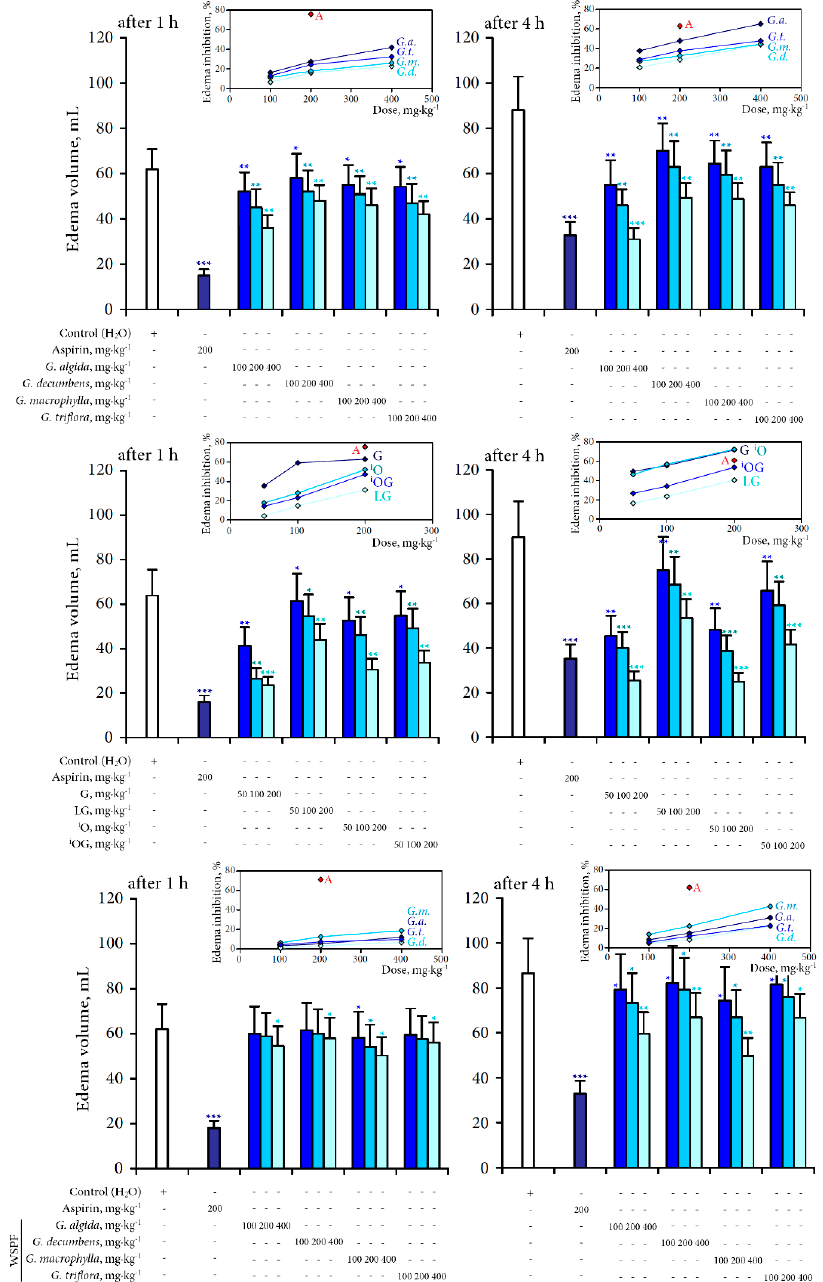
Figure 2. Anti-inflammatory activity of four gentian teas and individual compounds on carrageenan-induced paw edema in rats after 1 and 4 h after injection. Bars show the values of edema volume (mL). Values of edema shown are mean ± SD ( n = 12). Asterisks indicate statistically significant values from the control (*— p < 0.05; **— p < 0.01; ***— p < 0.001). On cuts—percentage of edema inhibition (A—aspirin, G.a. — G. algida , G.d—G. decumbens , G.m. — G. macrophylla , G.t. — G. triflora , G—gentiopicroside, LG—loganic acid-6 ′ - O - β - D -glucoside, i O—isoorientin, i OG—isoorientin-4 ′ - O - β - D -glucoside, WSPF—water-soluble polysaccharide fractions). Anti-inflammatory activity of water-soluble polysaccharide fractions of four gentians characterised as week after 1 h after injection of phlogogenic agent comparing with activity of crude decoctions and phytochemicals. Only G. macrophylla water-soluble polysaccharide fraction in dose 100–400 mg/kg